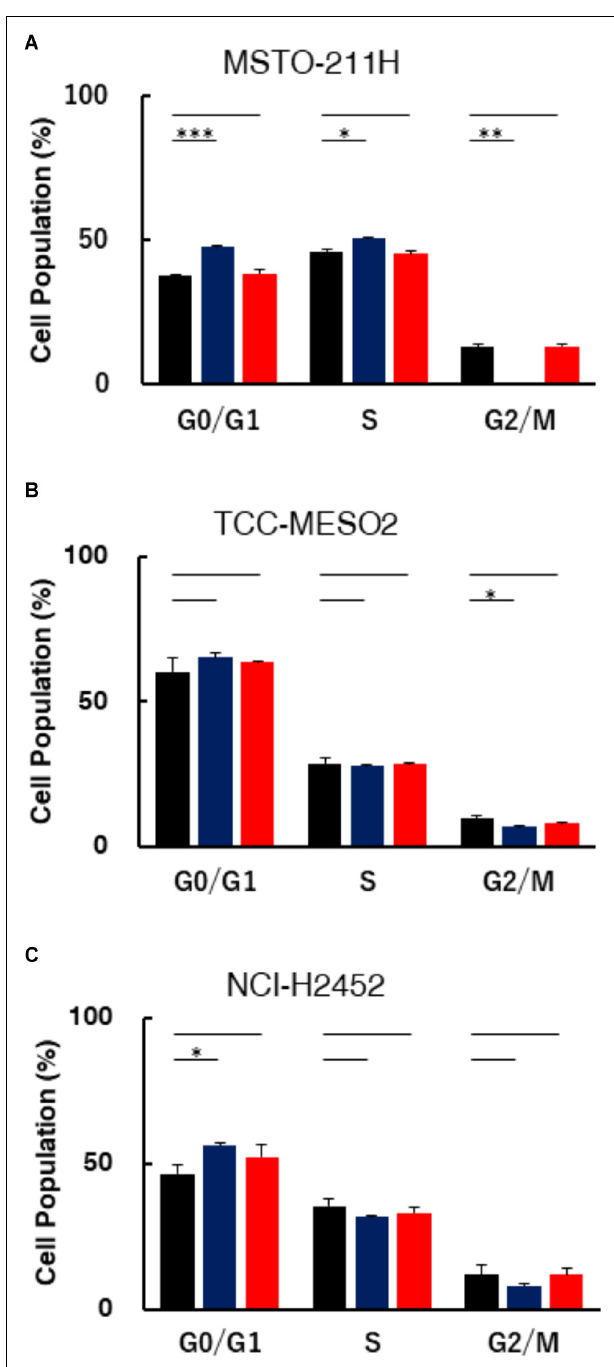
FIGURE 3 | Assessment of DNA content in MPM cells treated with pemetrexed. Treatment with pemetrexed arrested cell cycle in both the pemetrexed-sensitive MSTO-211H (A) and TCC-MESO2 (B) , and the PMX-resistant NCI-H2452 (C) MPM cells. After 6 h of 1 µ M pemetrexed treatment, the cells were analyzed for DNA content via PI staining. The percentage of cell populations in the G0/G1, S, and G2/M phases. Black: PBS, Blue: Pemetrexed (PMX) 1 µ M, Red: PMX 1 µ M + 100 µ M hypoxanthine + 16 µ M thymidine (HT). The data were shown as means ± s.d. From at least three independent experiments ( n = 3). ∗ P < 0.05, ∗∗ P < 0.01, ∗∗∗ P < 0.001 vs. control by two-tailed Student’s t